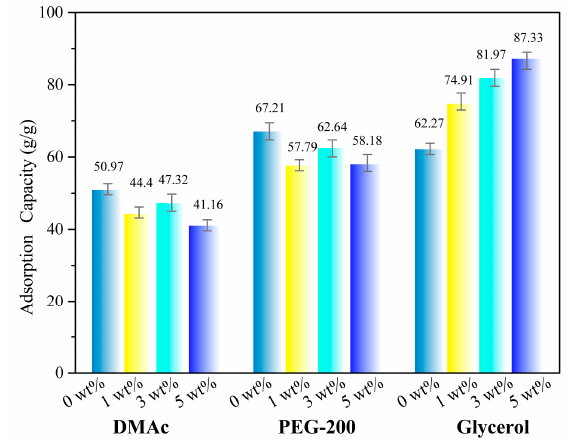
Figure 7. Adsorption capacity of CMC/CNTs aerogels.